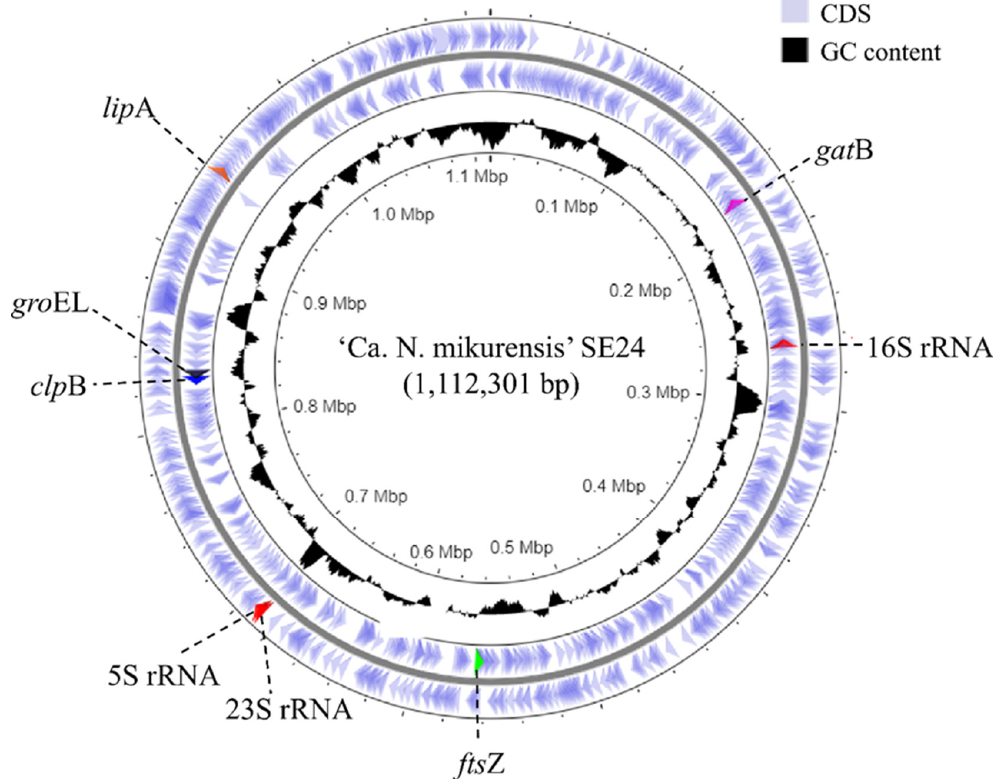
Figure 2. Circular representation of the chromosome of the reference genome of Ca . N. mikurensis strain SE24. From inside to outside, the first circle represents the genome size (Mbp), the second circle represents G + C contents (%), the third and fourth circles represent the coding sequences (CDS) on terminus and plus strands, respectively. The location of previously published MLSA genes and the complete ribosomal RNA genes (5S rRNA, 16S rRNA and 23S rRNA) within the genome are shown.